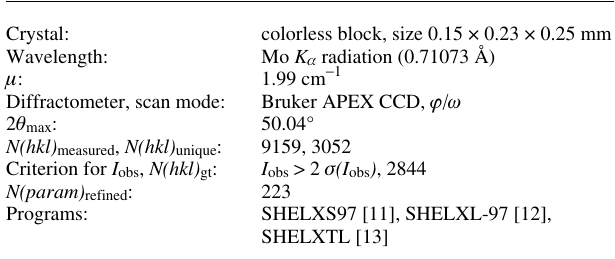
Table 1. Data collection and handling.